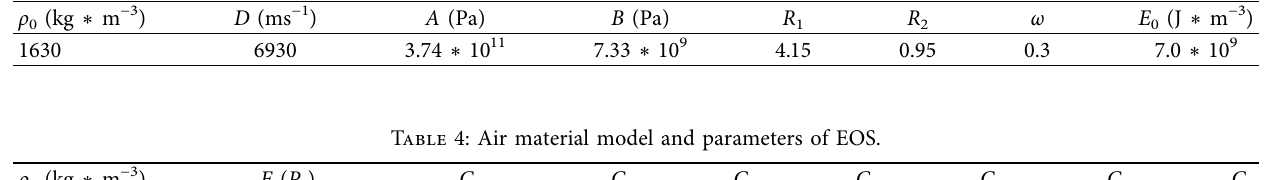
Table 3: TNT explosive material model and parameters of EOS.